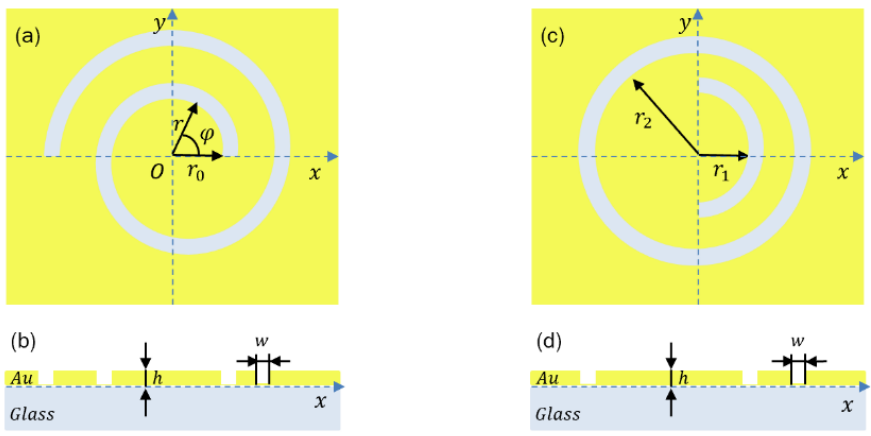
Figure 3. Schematic diagram of the PL structure consisting of a circle of one-and-a-half turns of ( a , b ) spiral slits and ( c , d ) symmetry-breaking circular slits.